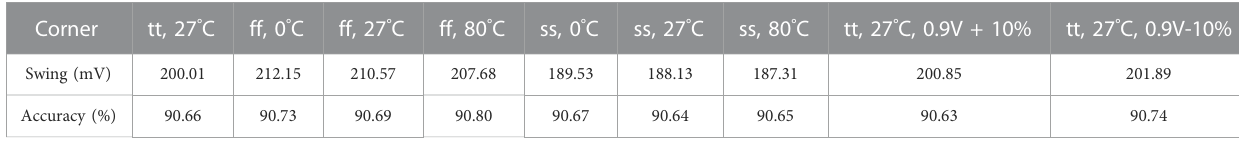
TABLE 1 Benchmark of ResNet18/CIFAR-10, considering the PVT, noise, and interference. Corner